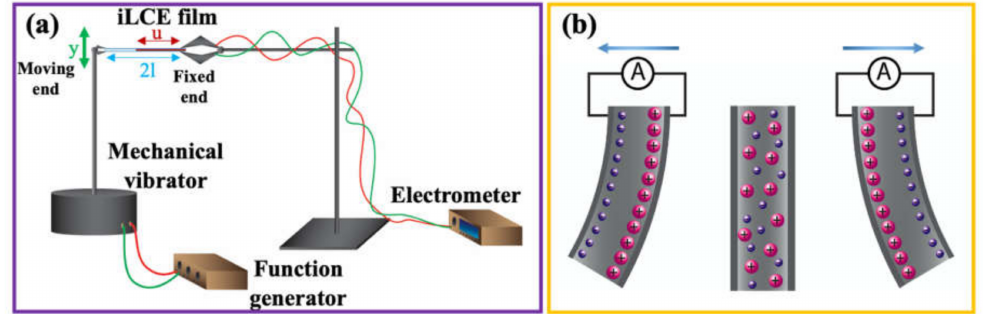
Figure 6. The schematic of the experimental setup, and the illustration of the physical mechanism of the flexo-ionic effect. ( a ) The schematic of the experimental setup to study flexo-ionic effect. ( b ) Illustration of the principle of the flexo-ionic effect.